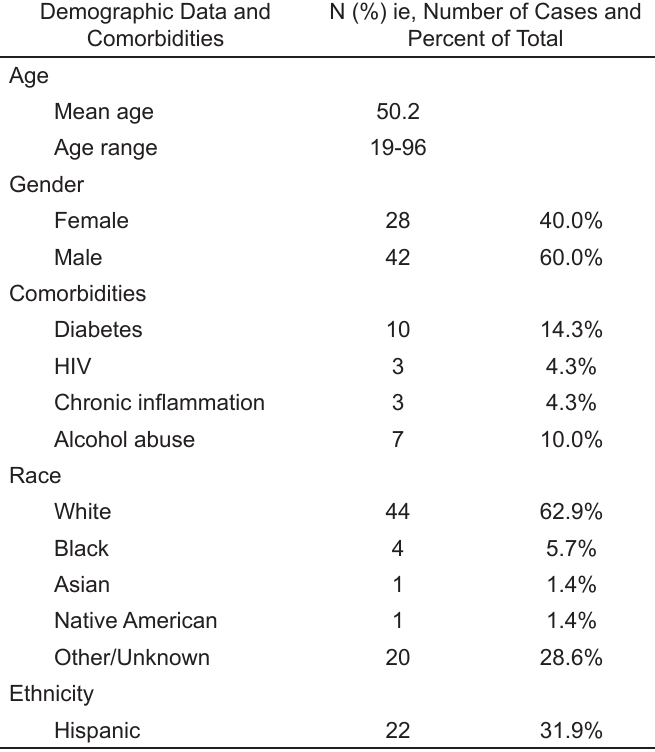
Table 1. Demographic data and